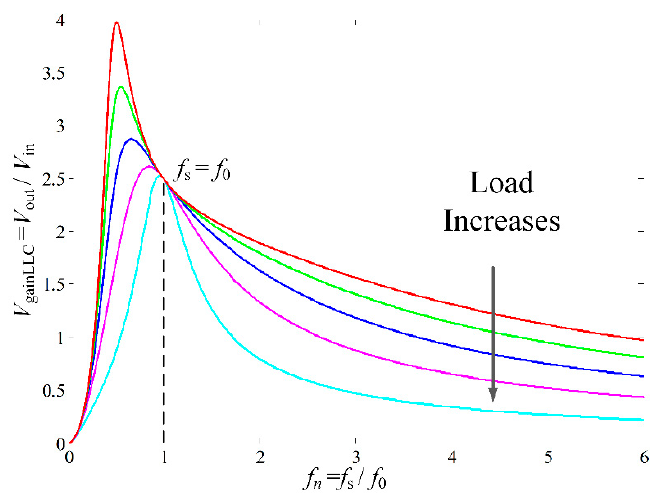
Figure 3. DC voltage gain curves of an LLC resonant converter.